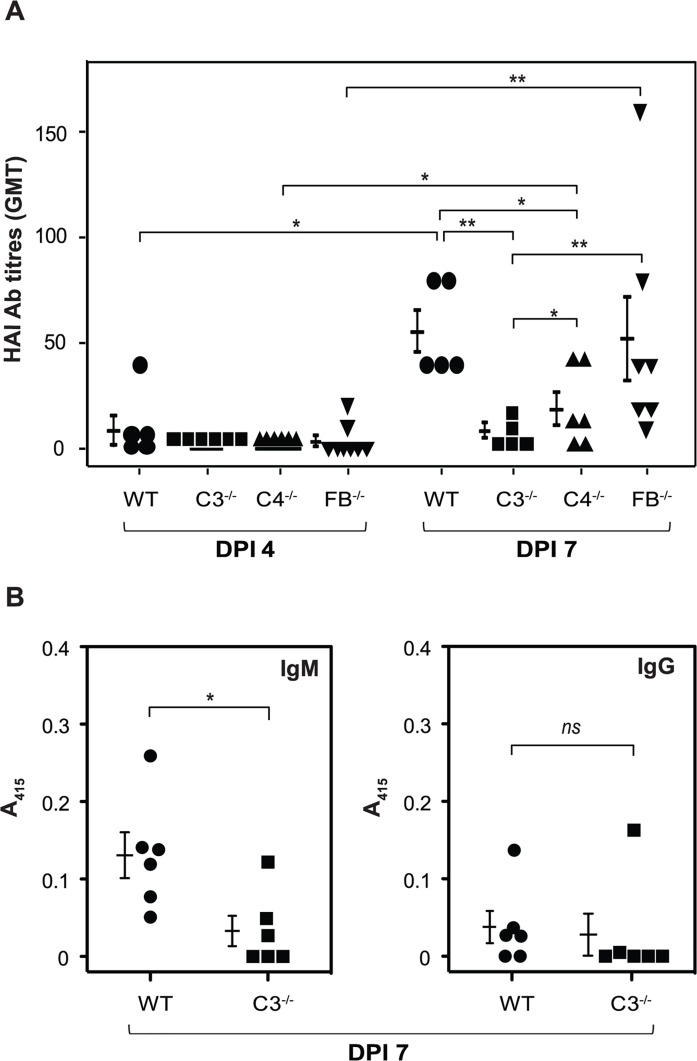
Antibody response to hemagglutinin is significantly reduced in pandemic influenza virus infected C3-/- and C4-/- mice, but not FB-/- mice.WT (C57BL/6) and complement deficient mice (C3-/-, C4-/- and FB-/- mice on C57BL/6 background) were infected intranasally with the pandemic influenza virus (450 TCID50), euthanized at day 4 and 7 post-infection, and serum was collected to determine the HA-specific antibody response. A) HAI antibody titers. Data are plotted as Geometric mean titers (GMT). Bars represent mean ± SD of three independent experiments. *p < 0.05 and **p < 0.002 (Mann–Whitney Rank Sum test, IBM PASW). B) HA-specific IgM and IgG levels as measured by ELISA. Bars represent mean ± SEM. *p < 0.02; ns—not significant (Mann–Whitney Rank Sum test, IBM PASW).